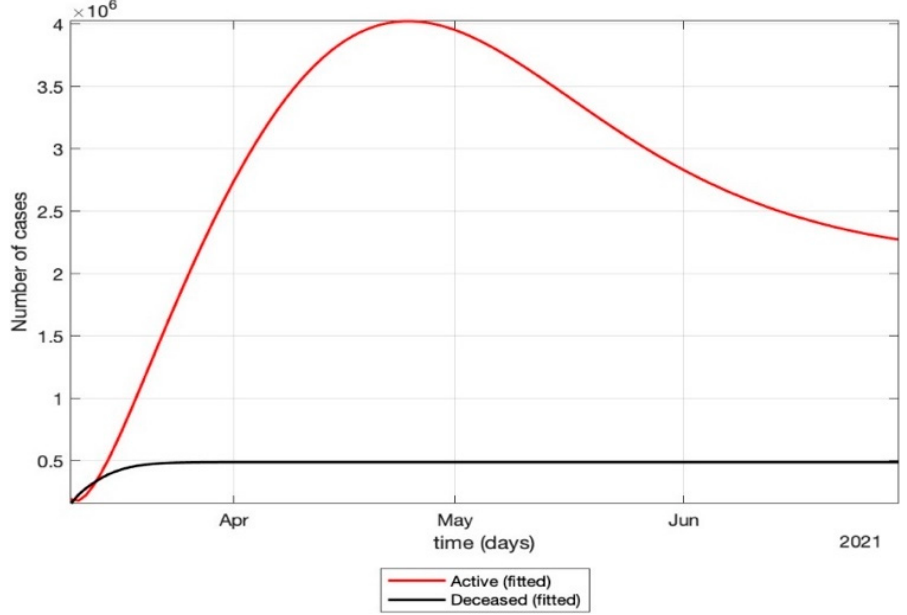
Figure 11. Prediction of the proposed model (1) for the number of COVID-19 cases in 2021 (second wave).